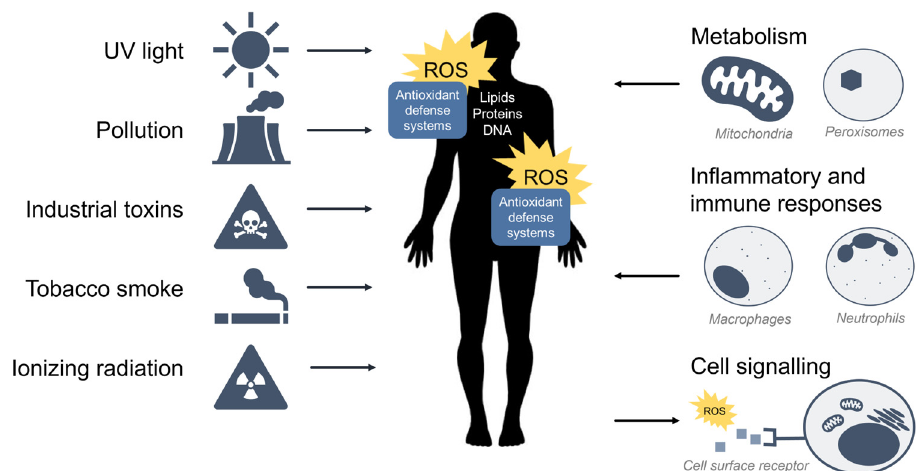
Figure 1. Sources of exogenous and endogenous ROS. ROS can come from toxic exogenous sources in the environment, or be produced as by-products of normal cell metabolism, inflammation, and immunity. ROS may also function as secondary messengers within cell signalling pathways.